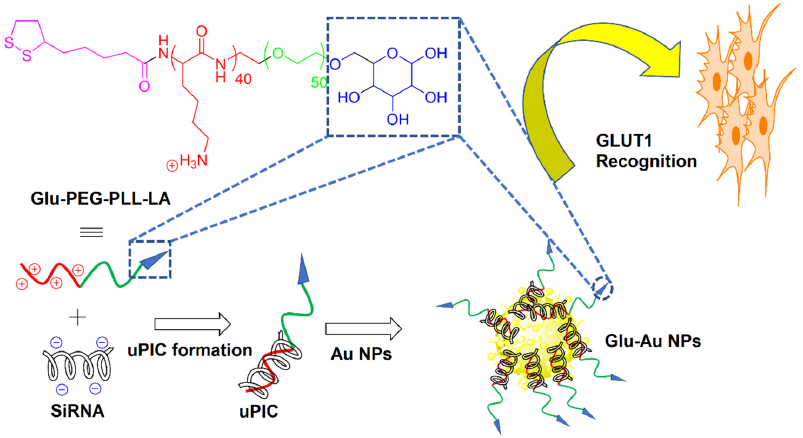
Figure 5. Schematic diagram of the two-step bottom-up approach for the synthesis of self-assem- bled Glu AU NPs. Reprinted with permission from ref. [81], Copyright 2014 American Chemical Society.